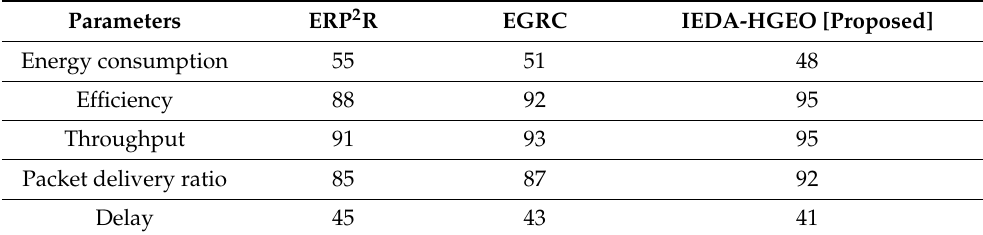
Table 2. Comparison of various parameters for the proposed